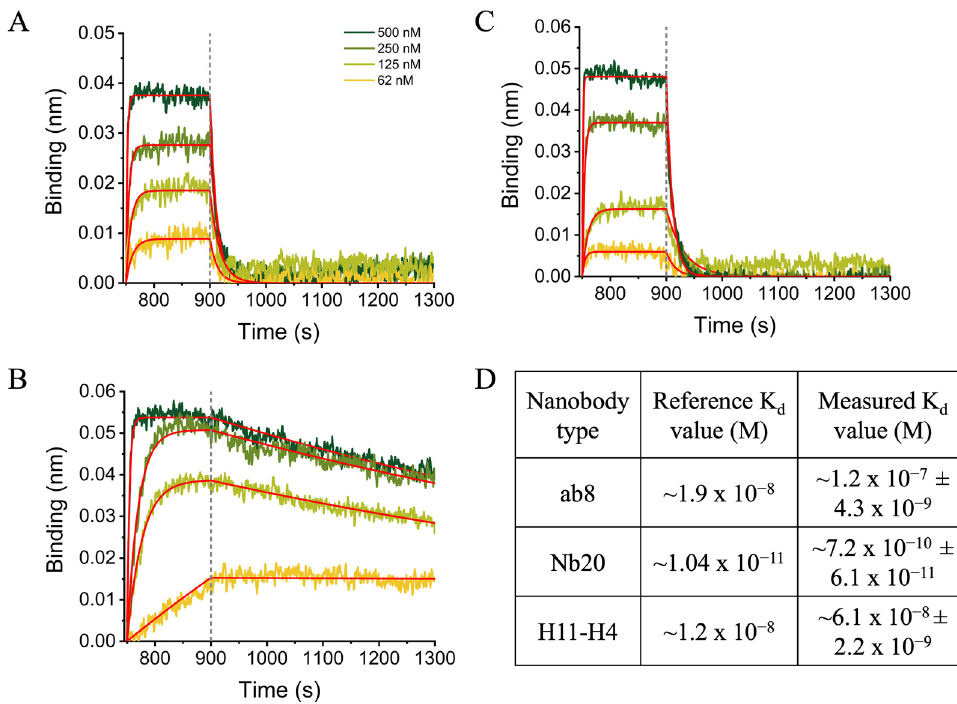
Figure 4. Binding of ( A ) ab8; ( B ) Nb20; and ( C ) H11-H4 anti-Spike antibody variants to the full-length Spike protein at different concentrations. The dissociation of the Nb20-Spike protein complex is much slower compared to ab8 and H11-H4, explaining the higher affinity of Nb20 to the Spike protein (K d ~1 nM). Dashed lines represent the end of association. Table ( D ) contains the collected reference and measured K d values .